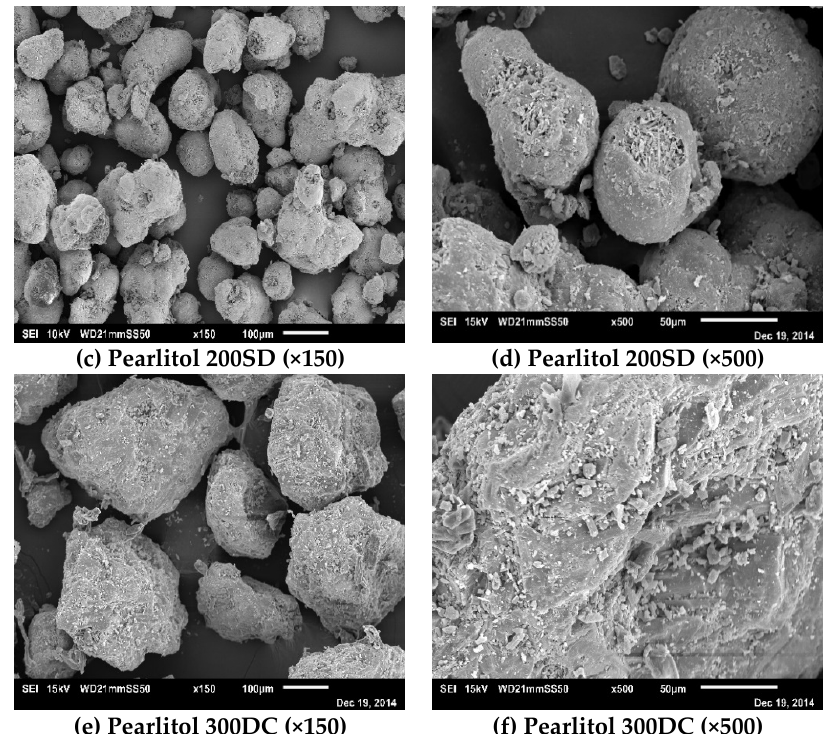
Figure 3. SEM images of mannitol powders.